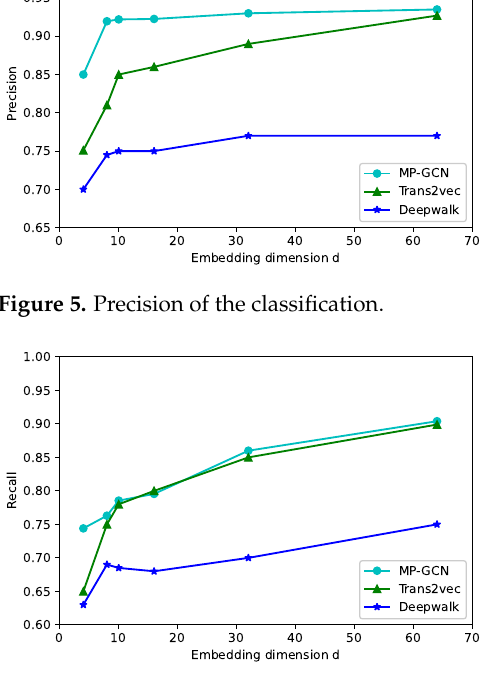
Figure 6. Recall of the classification.